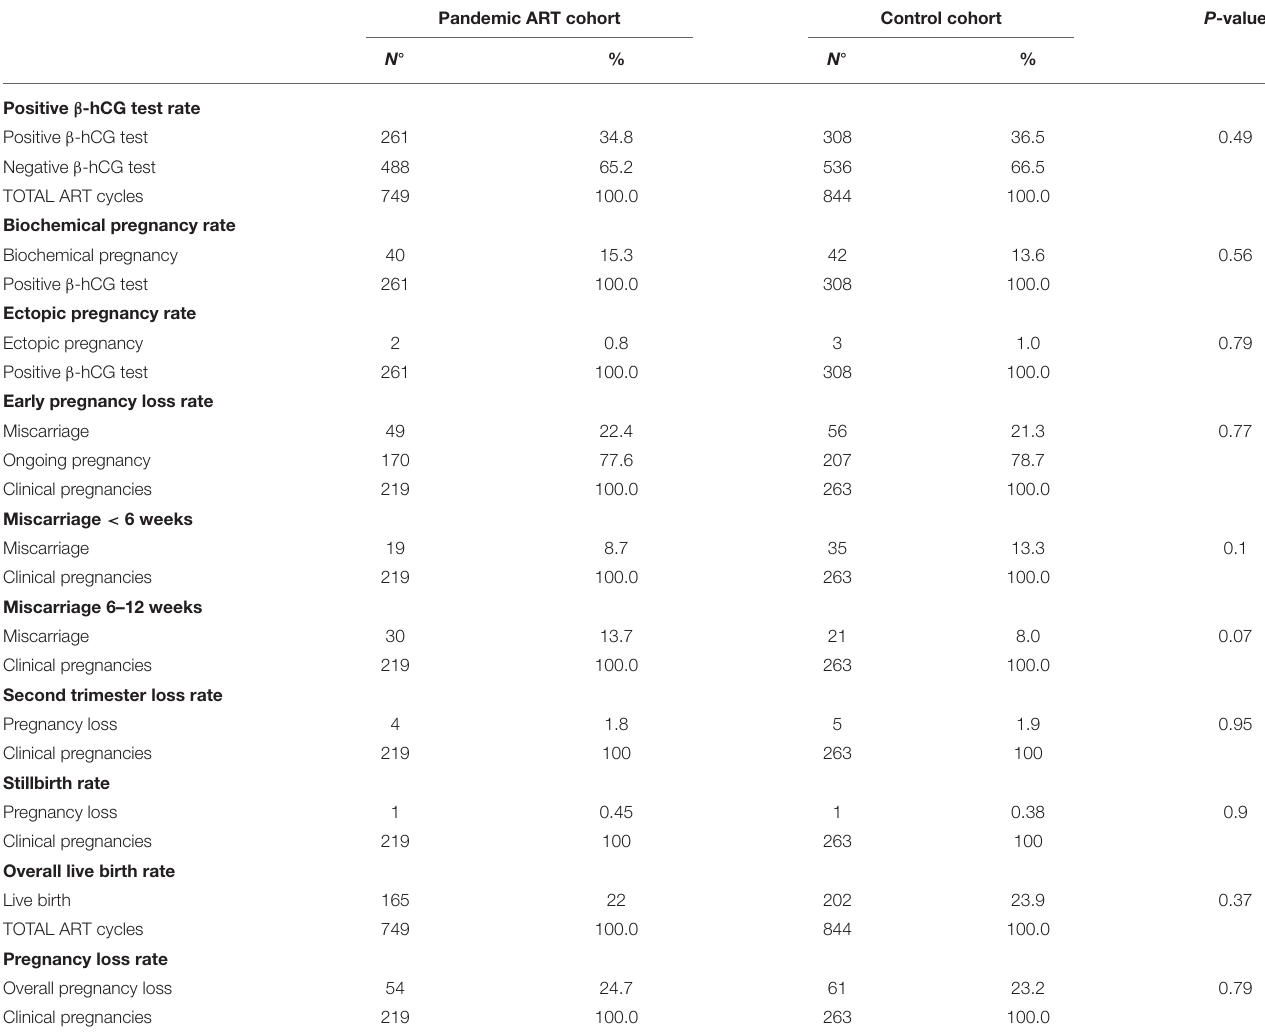
TABLE 2 | The outcome of assisted reproductive technology (ART) pregnancies in the pandemic ART cohort and in the control cohort: results. Pandemic ART